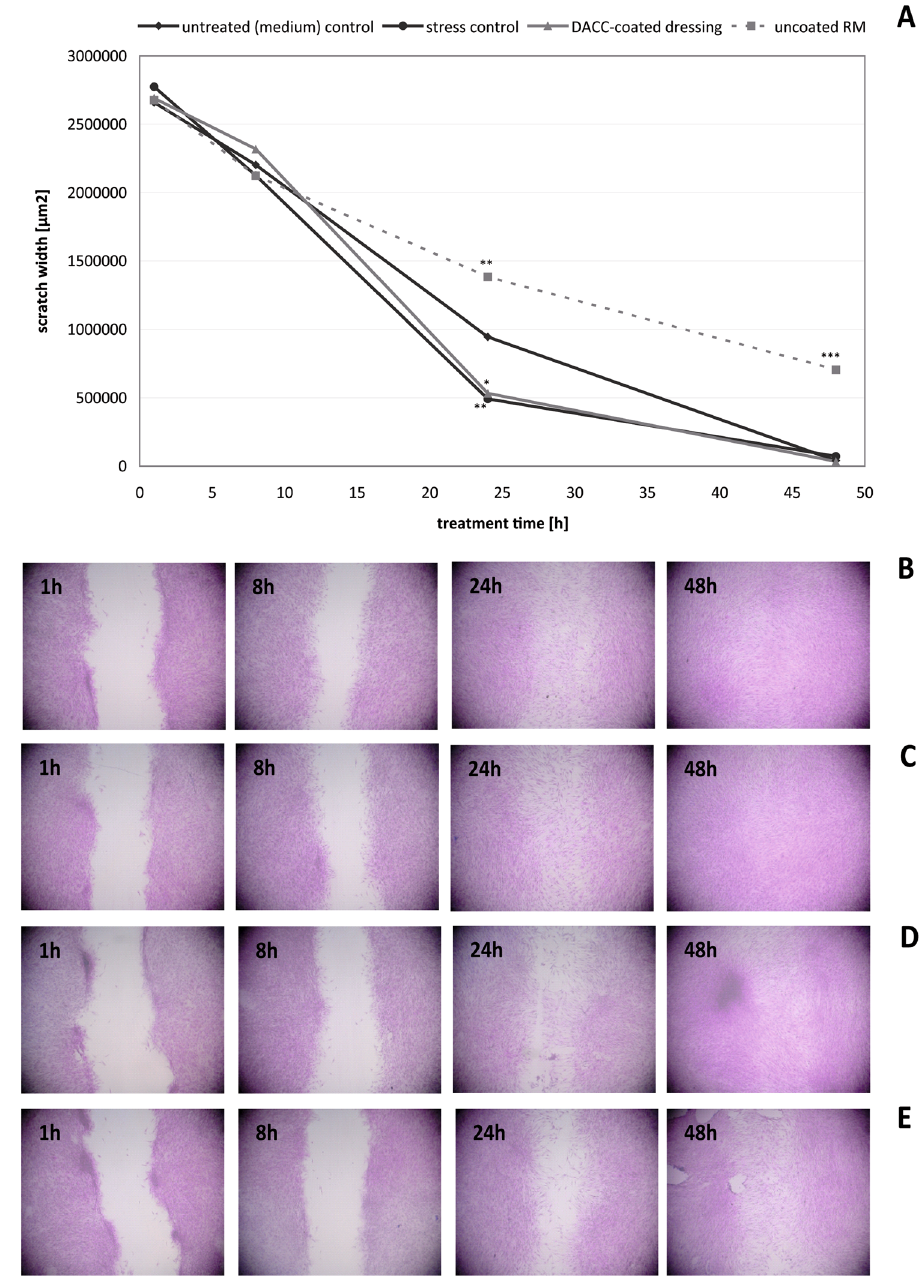
Fig. 4 Progression of NHDF scratch healing ( A ) in the untreated (medium) control ( B ) and the stress control ( C ) as well as under treatment with DACC ( D ) and untreated RM ( E ) after 1, 8, 24, and 48 hours (h). Asterisks indicate a signi fi cant deviation at the respective time point from the untreated control (* p < 0.05; ** p < 0.01; *** p <